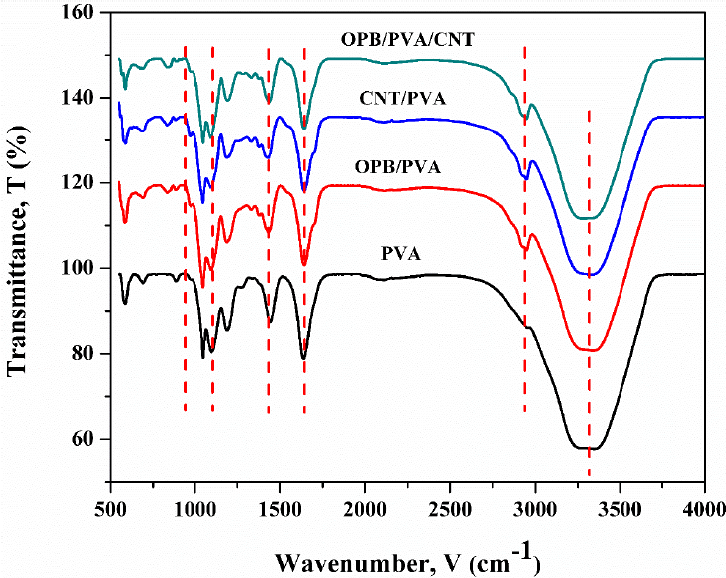
Figure 4. FTIR analysis of PVA, OPB/PVA, OPB/PVA/MWCNTs and OPB/MWCNTs hydrogels,